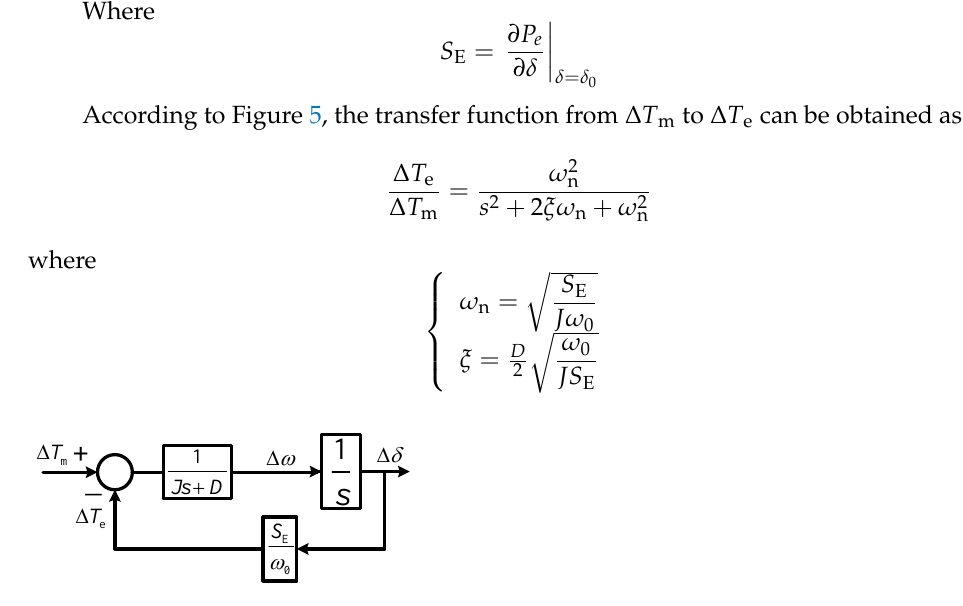
Figure 5. Small signal model of P-f control diagram of VSG.